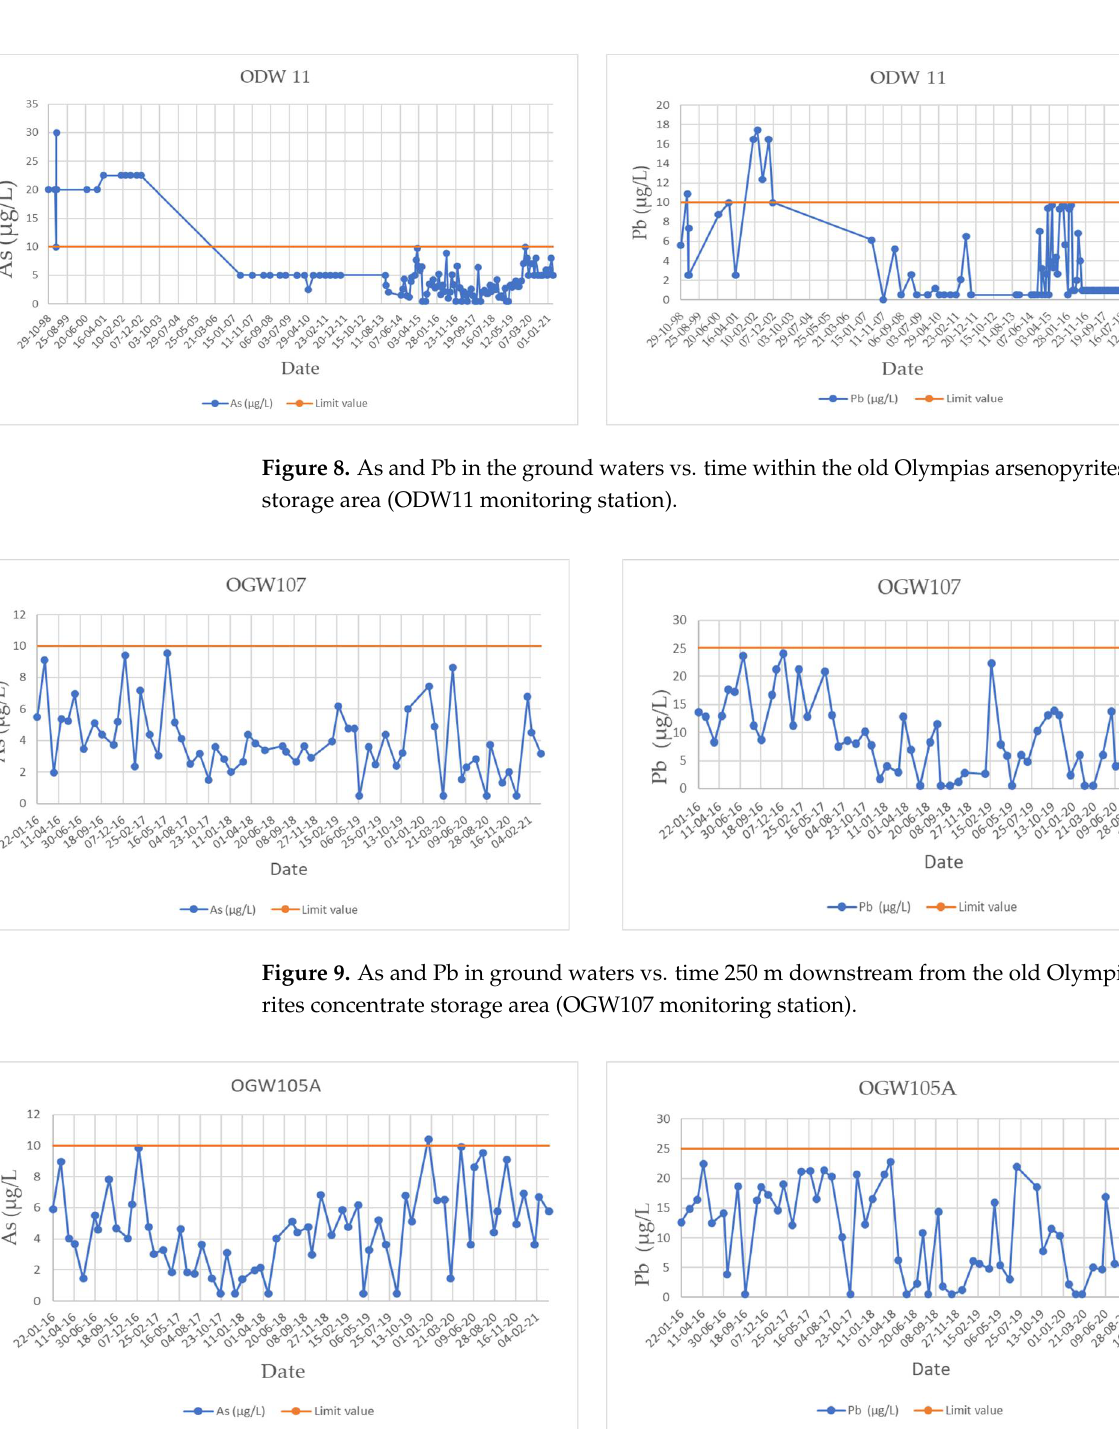
Figure 7. Monitoring of ground waters in the immediate area of the old Olympias arsenopyrites concentrate storage area (former METBA plot).